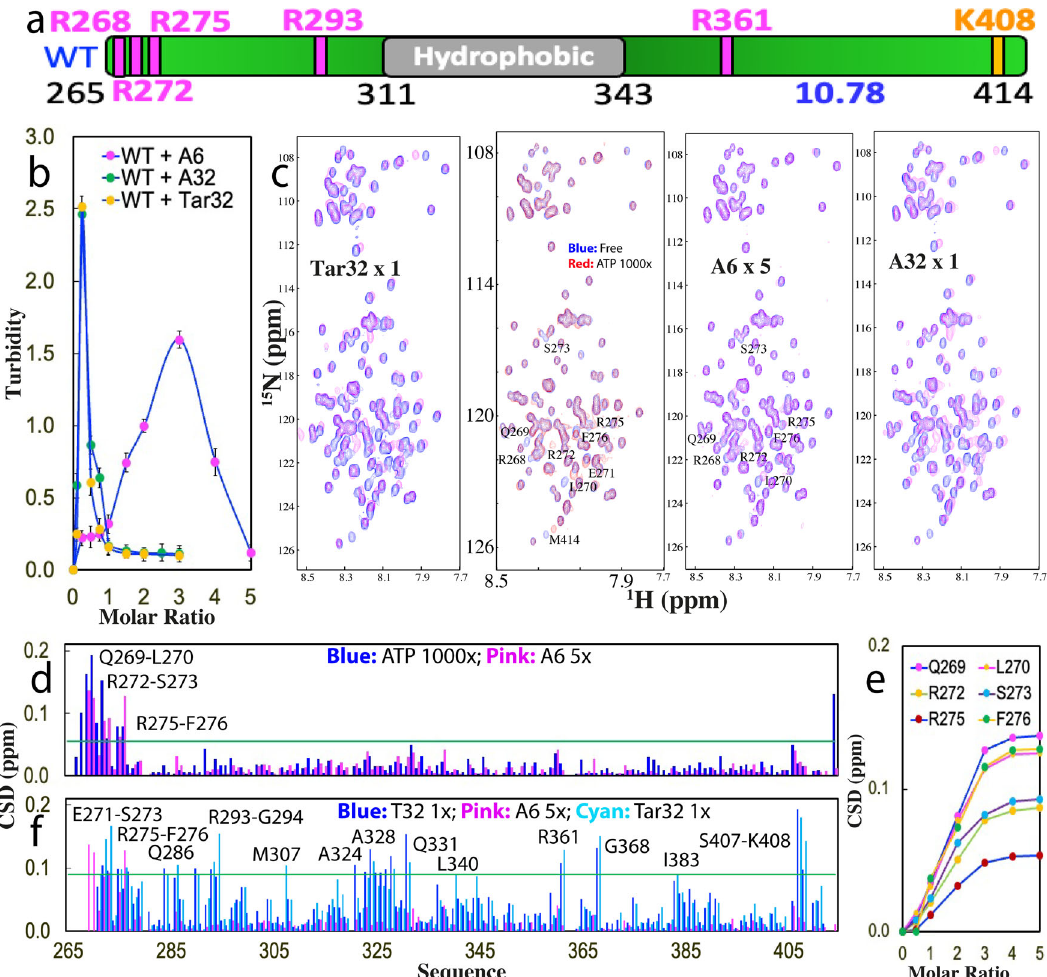
Fig. 1 Three ssDNAs length-dependently modulate LLPS of TDP-43 WT-PLD. a Schematic representation of TDP-43 WT-PLD with fi ve Arg and one Lys, as well as p I value indicated. b Turbidity curves from three repeated measurements ( n = 3) of WT-PLD in the presence of Tar32, A6, and A32 at different molar ratios. c 1 H – 15 N NMR HSQC spectra of the 15 N-labeled WT-PLD in the absence (blue) and in the presence of ATP at a molar ratio of 1:1000 (red), as well as A6 at 1:5, A32 and Tar32, respectively, at 1:1 (purple). d Chemical shift difference (CSD) of WT-PLD between the free state and in the presence of ATP at 1:1000 (blue) or A6 at 1:5 (purple), respectively. The green line is used to indicate the value (0.05): Average + STD at the ratio of 1:5. The residues with CSD values> Average + SD are de fi ned as signi fi cantly perturbed residues and labeled. e CSD tracings of six signi fi cantly perturbed residues in the presence of A6 at different ratios. f Chemical shift difference (CSD) of WT-PLD between the free state and in the presence A6 at 1:5 (purple), A32 at 1:1 (blue), and Tar32 at 1:1 (cyan), respectively. The green line is used to indicate the value (0.09): Average + STD in the presence of Tar32 at the ratio of 1:1 (PLD: Tar32). The residues with CSD values > Average + SD are de fi ned as signi fi cantly perturbed residues and